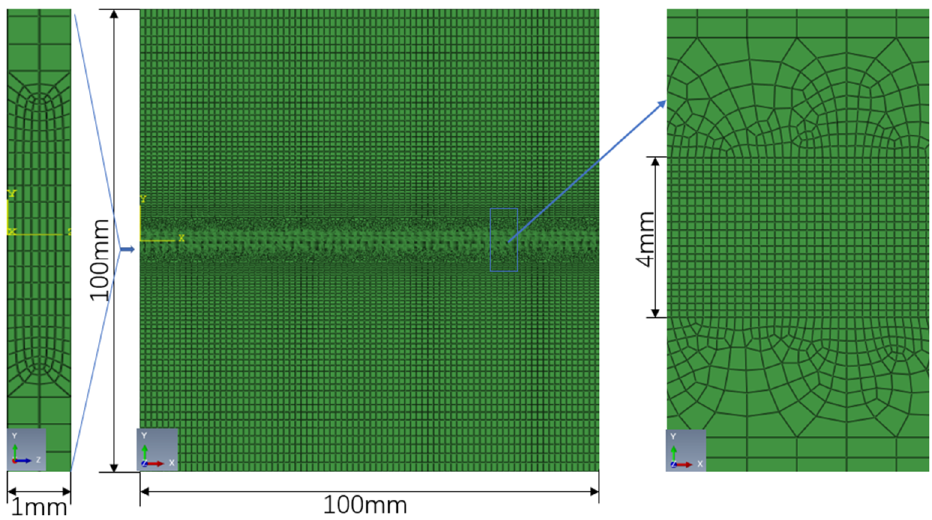
Figure 3. The mesh configuration of the three-dimensional model employed in the FEM